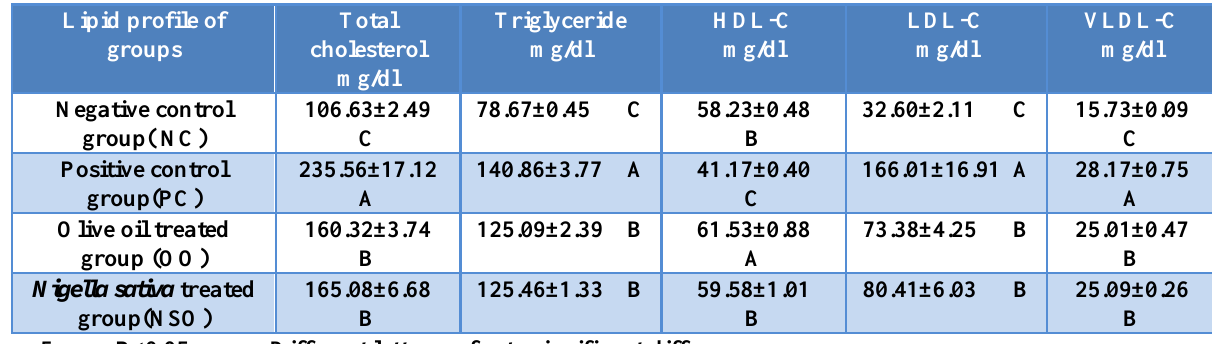
Table, 1: The lipid profiles test parameters of different male mice groups after two months